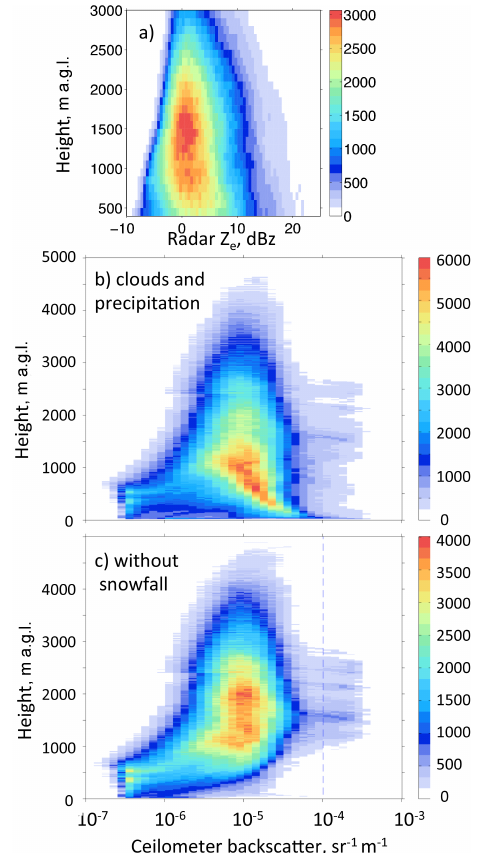
Figure 6. Number of occurrences by height on 1min temporal scale for (a) MRR effective reflectivity ( Z e ), (b) ceilometer backscatter for all cloudy/precipitation profiles, and (c) ceilometer backscat- ter for cloudy profiles excluding snowfall cases (see Sect. 4.2.1). Based on the measurement periods during 2010–2013 (14 months of cloud measurements mainly in summer–beginning of winter and 26 months of snowfall measurements including an entire year; see Table 1). The dashed vertical line indicates the threshold used for liquid-containing layers identification.